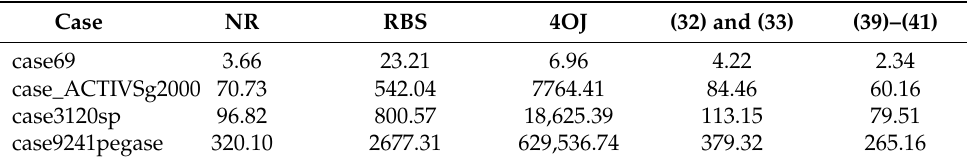
Table 7. Solution times (ms) for well-conditioned cases.